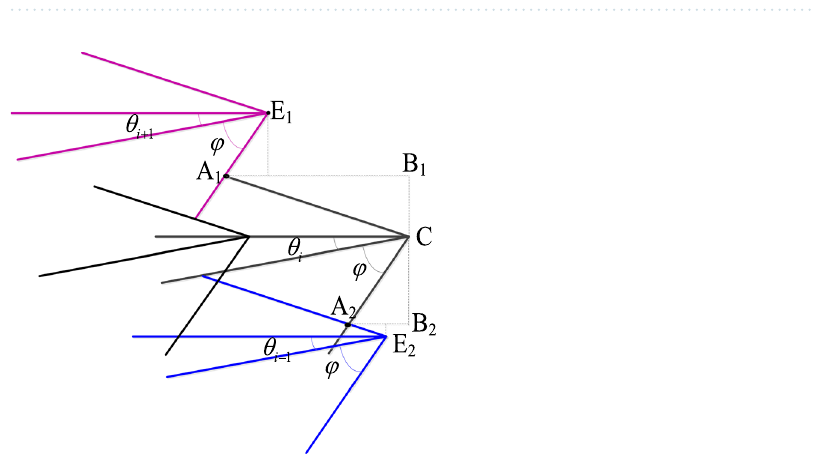
Figure 6. Pick arrangement diagram: ( a ) equidistance; ( b ) equidifference.